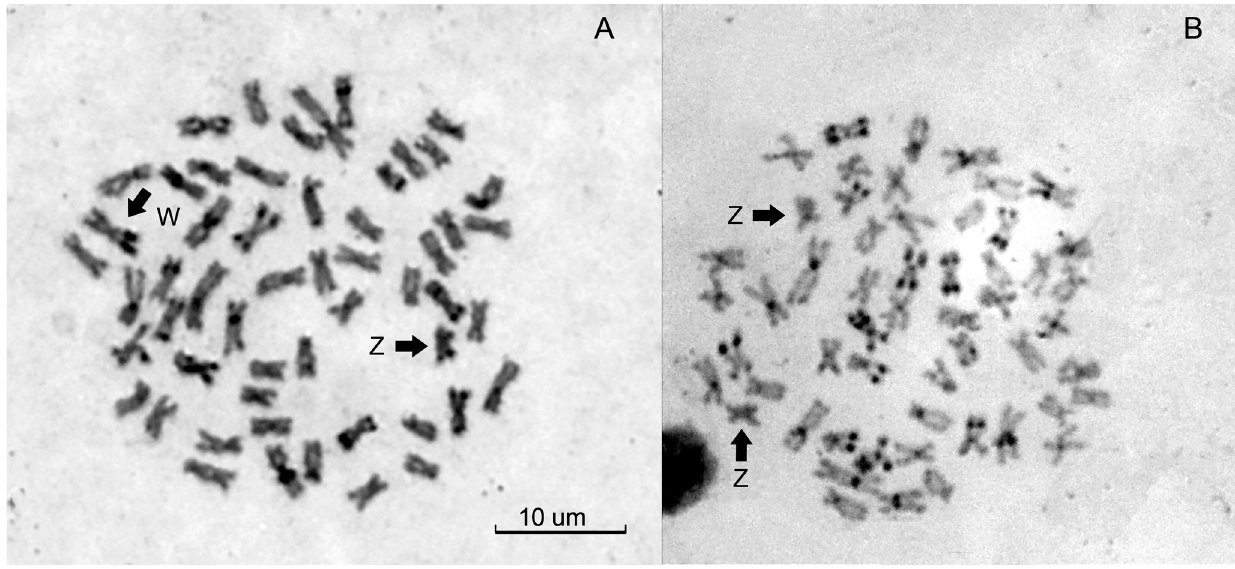
FIGURE 3 | Saccodon wagneri C-banded metaphases. A . Female; B . Male. The arrows indicate the sex